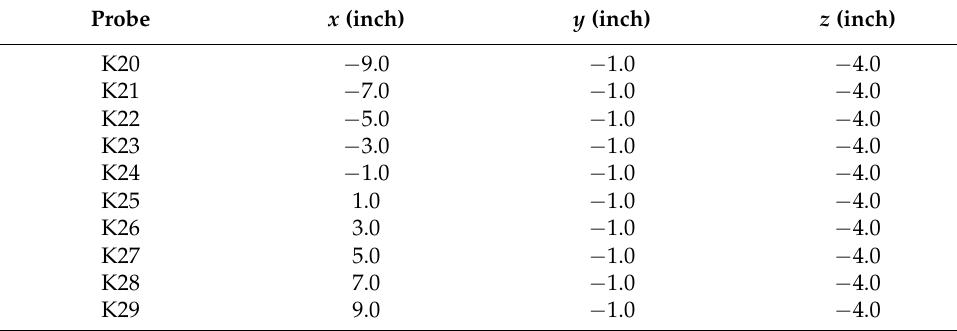
Table 2. Location of the Kulite